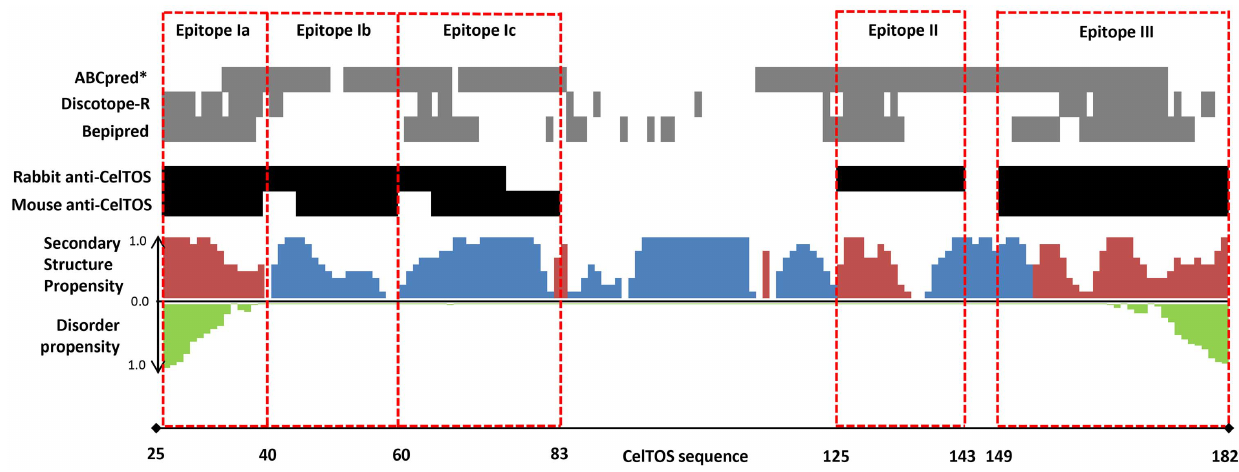
Figure 3. Consolidation of structural properties from insilico predictions and invivo immune responses. Computational epitope predictions (gray) are shown for ABCpred , Discotope , and Bepipred . Experimental epitope mapping using antibody peptide scanning (black) from both rabbit and mouse anti- Pf CelTOS serum antibodies are significant above an OD-cutoff of the mean background responses plus three standard deviations from the mean. Computational secondary structure propensities for a -helix (blue), coiled (red) regions and disordered propensity (green) reported in a relative scale 2 1 to 1. All computational epitope definitions are based on classifications using default score cutoff values for Discotope and Bepipred . Score cutoff for ABCpred was optimized to maximize accuracy. Only results from computational methods with statistically significant predictions ( p , 0.001) are shown.